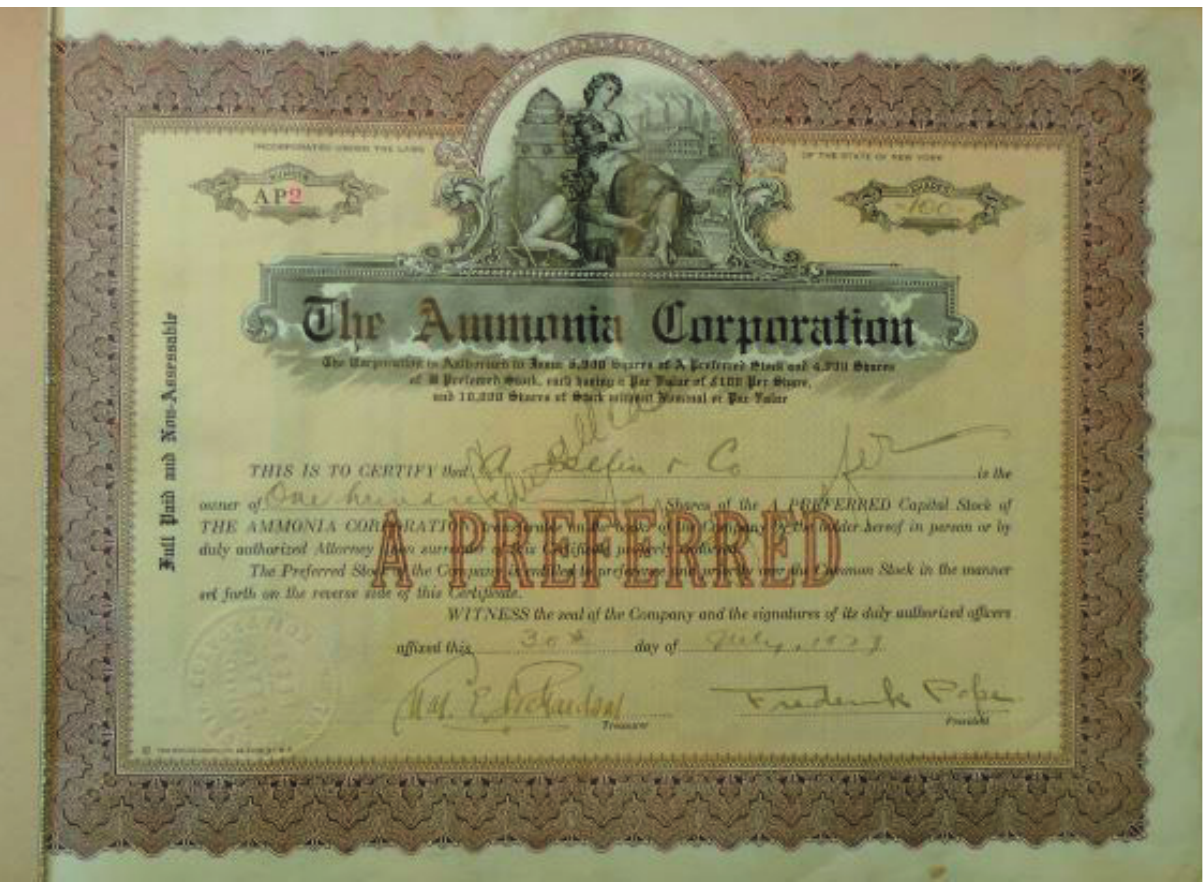
Figure 2. Stock certificate, The Ammonia Corporation, preferred stock, assigned to A. Iselin & Co., 30 July 1923. Iselin held the stock cer- tificates of Ammonia Casale SA holdings in The Ammonia Corporation and the Hydro-Electric Chemical Company. From: The Ammonia Corporation, A Preferred Stock. Records of E.I. Du Pont de Nemours & Co. Absorbed companies. Manuscripts and Archives Department, Hagley Museum and Library, Wilmington, Delaware, Accession 500, series II, part 1, box 67. Author’s photograph. Reproduced with per-